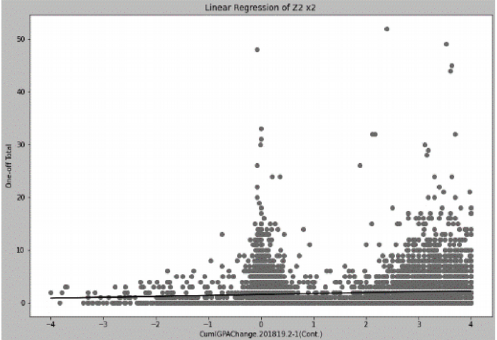
Figure 4. Linear Regression of Z2 x2 in Finding